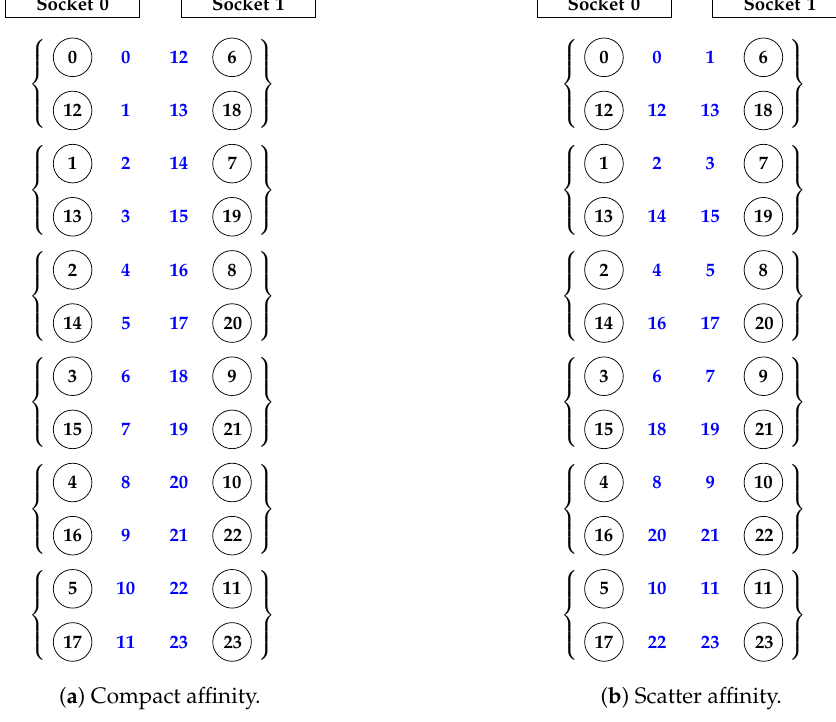
Figure 4. Affinities setup on a Workstation with 2 sockets and 6 cores by socket, with HT enabled. Cores are identified with circles. Curly brackets mean that the virtual cores are handled by the same physical core. The blue numbers indicate the order of assignment of the threads.